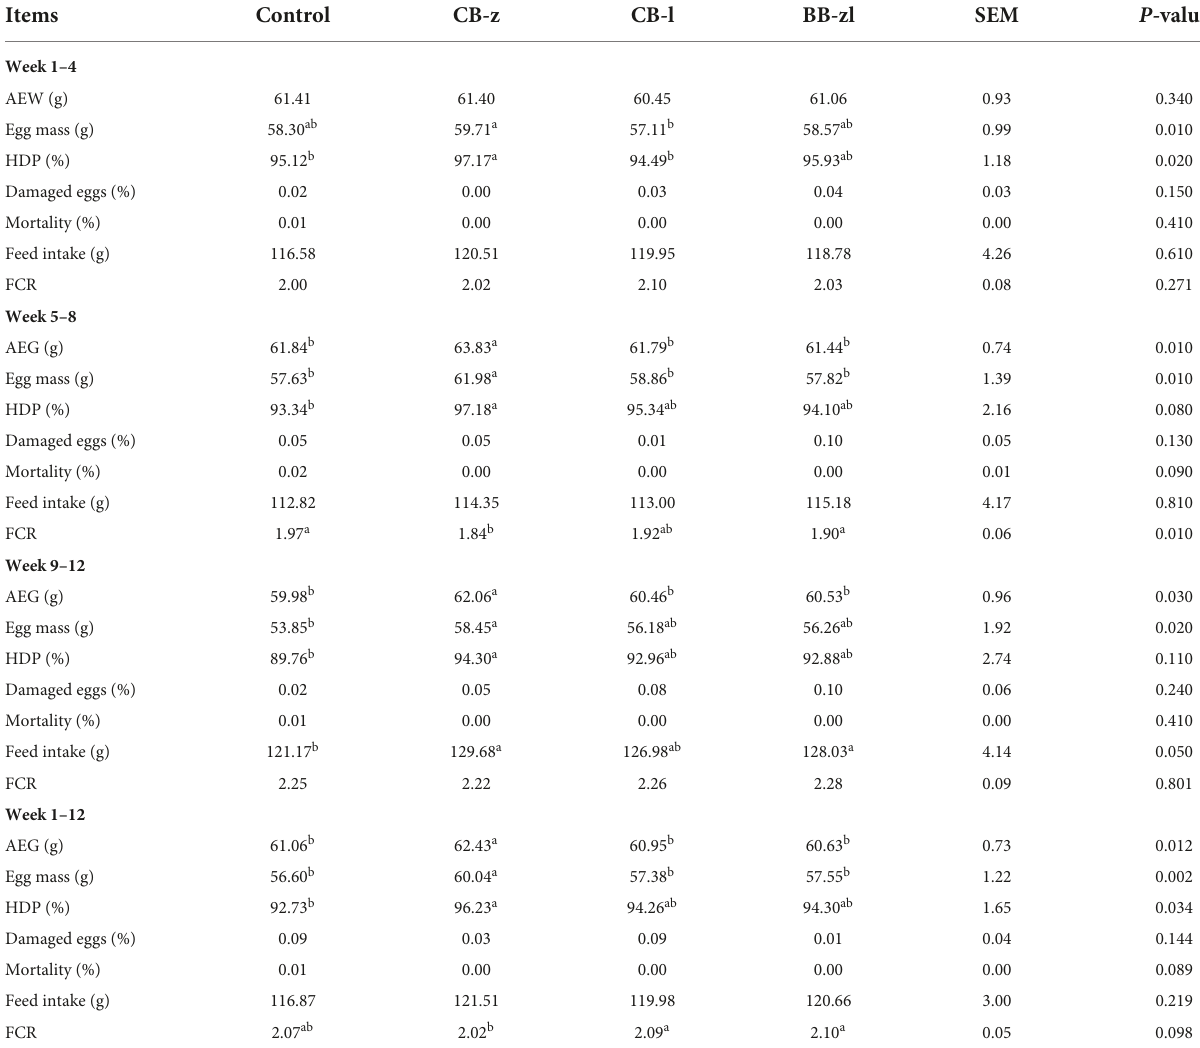
TABLE 2 Effects of Clostridium butyricum and Brevibacillus sp. on the performance of laying